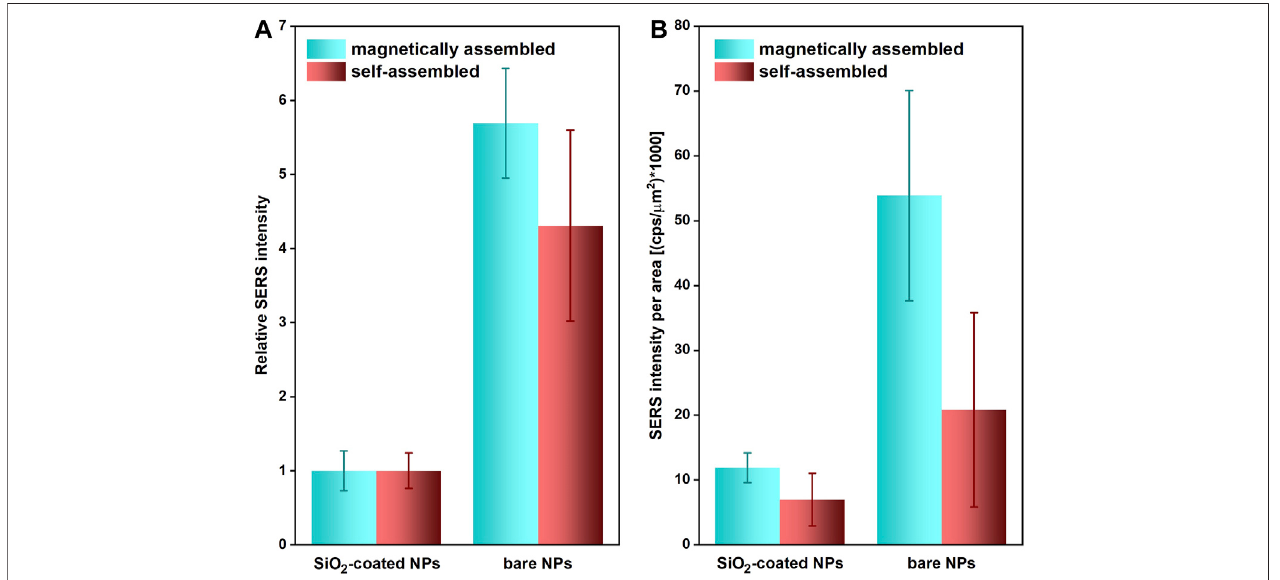
FIGURE 9 | (A) Changes of the average intensity of MES SERS band around 790 cm − 1 (with error bars showing the RSD values) for magnet- and self-assembled (ordered region) samples of bare and SiO 2 -coated Fe 3 O 4 /Ag@MES NPs onto glass substrate. Relative intensity corresponds to SERS signal with respect to this observed for the magnetically assembled silica-coated NPs (normalized to unity). The values of RSD were also recalculated according to this procedure. (B) Average intensityofMESSERSbandaround 790 cm − 1 (witherrorbars showingtheRSDvalues)dividedbytheexaminedareaformagnet- andself-assembled(disordered region) samples of bare and SiO 2 -coated Fe 3 O 4 /Ag@MES NPs onto glass substrate. Typically 25 spots localized across area not smaller than 6300 μ m 2 area were analysed in each